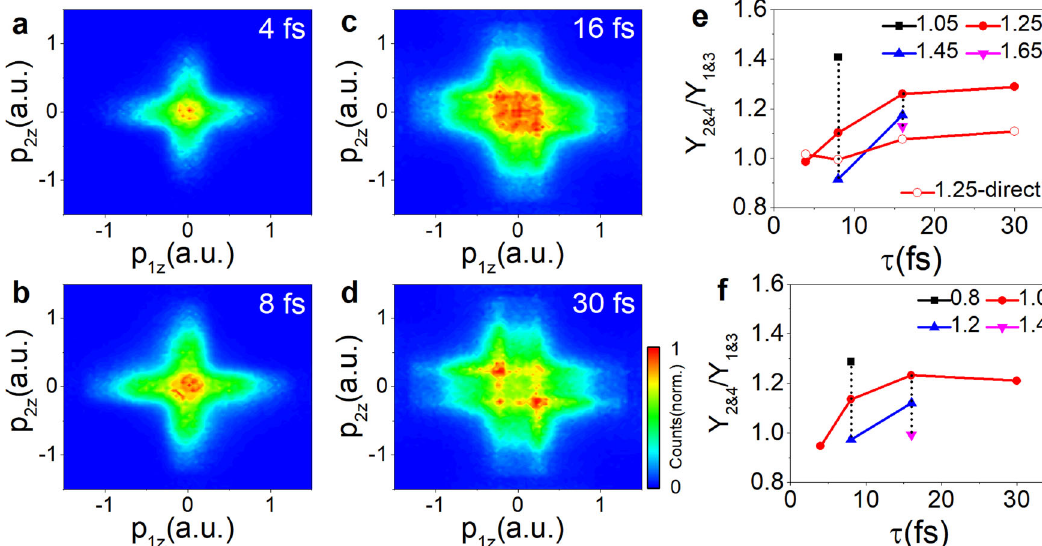
Fig. 2 Simulated results for below-threshold nonsequential double ionization of Ar. a – d Simulated correlated electron momentum distributions (CEMDs) of Ar for different laser pulse durations at the intensity of 1.25 × 10 14 W cm − 2 . The carrier-envelope phases are averaged. Each CEMD is normalized to itself. e Simulated yield ratio Y 2&4 / Y 1&3 for different pulse durations and different intensities. Y 1&3 ( Y 2&4 ) denotes the integrated yield in the fi rst and third (the second and fourth) quadrants in the CEMD. The numbers given in the legends denote peak laser intensities with units of 10 14 W cm − 2 . The open circles are calculated by only considering direct trajectories of e 2 (see text for details). f Measured results extracted from Ref. 25 . The black short-dashed lines in e and f serve as indications of the intensity dependence.